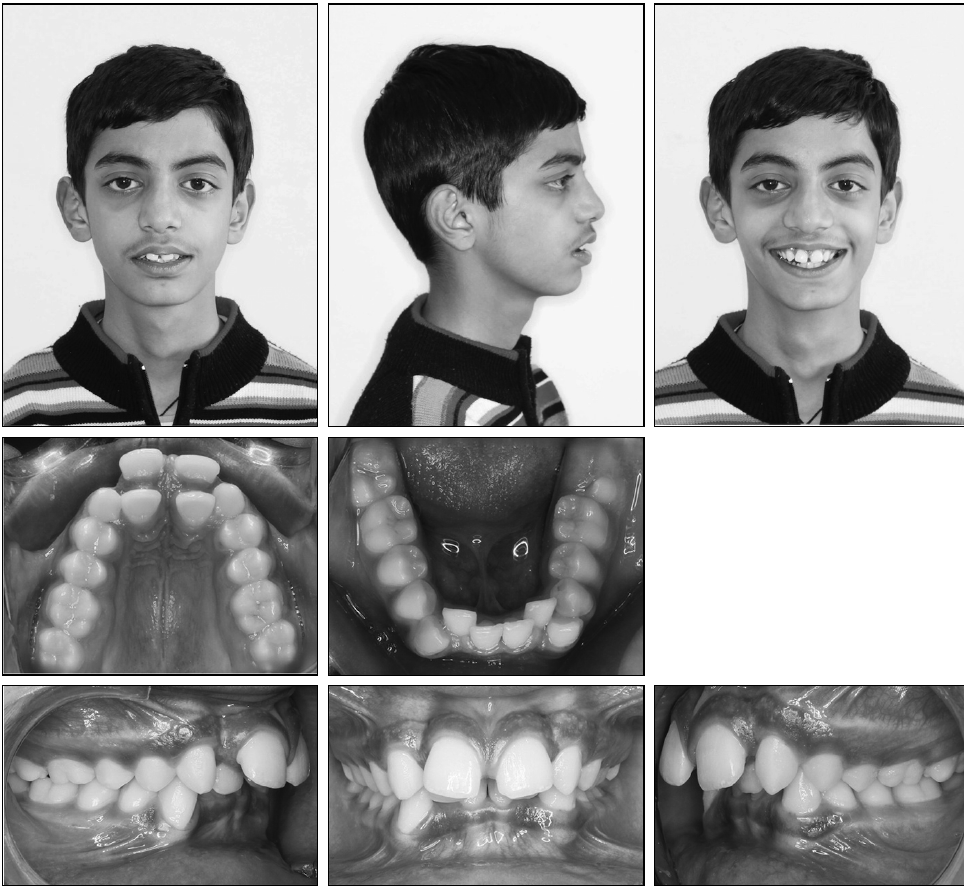
Figure 1a. Pretreatment.